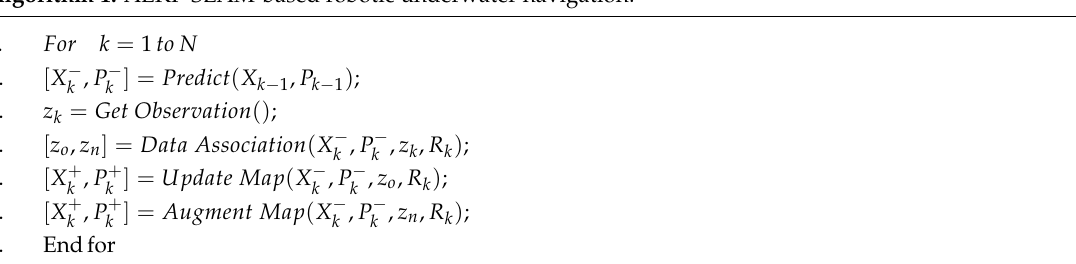
Figure 10. The architecture of the AEKF-SLAM-based robotic navigation system, as in [7]. Algorithm 1. AEKF-SLAM-based robotic underwater navigation.